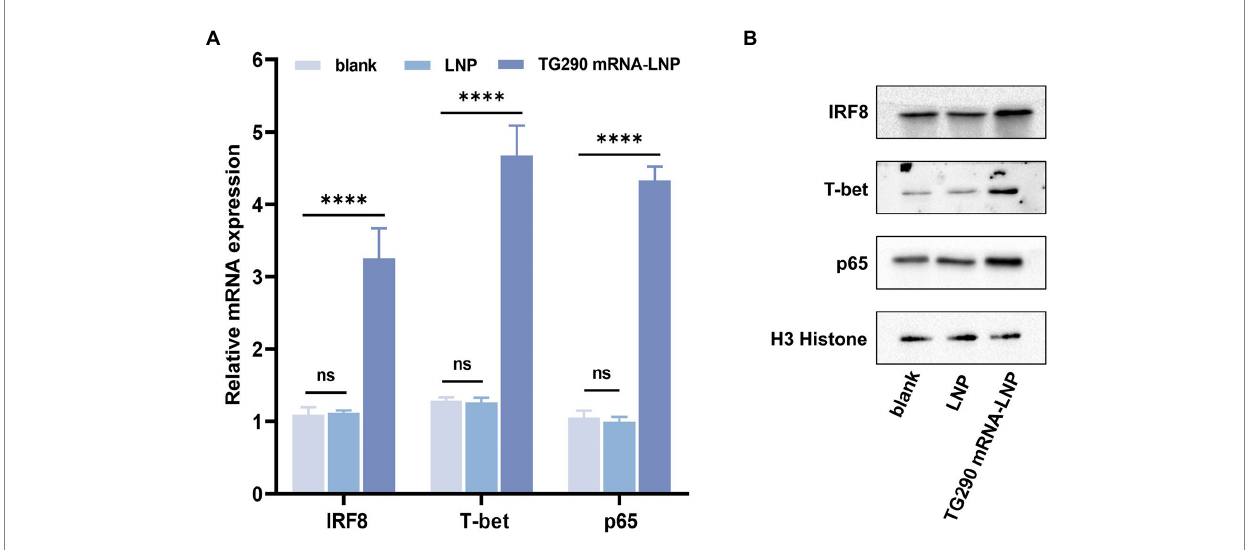
FIGURE 7 The mRNA and protein expression levels of IRF8, T-bet, and p65 in splenocytes. (A) The mRNA expression levels of IRF8, T-bet, and p65. (B) The protein expression levels of IRF8, T-bet, and p65. Data were obtained from triplicate independent experiments and are presented as means ± SD ( n = 5). **** p < 0.0001, analyzed by One-way ANOVA with multiple comparisons (compare the mean of each group with the mean of every other group).